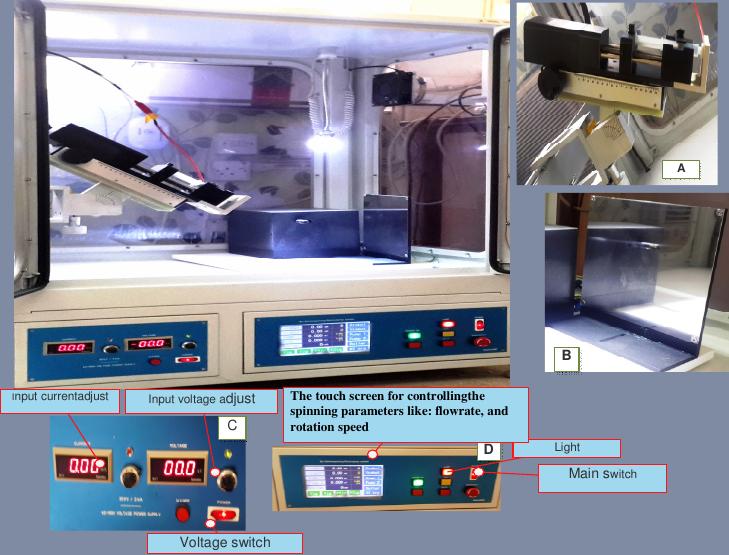
Fig. 2. Electrospinning device: a- syringe pump instruction, b- collector plate, c- power supply, d-touch control Board.